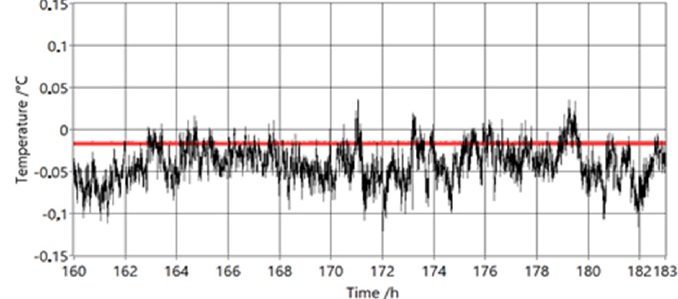
Figure 20. Temperature readings at calibration at ice point (last day). The red colour represents the reference thermometer and the black colour represents the raw un-averaged PAT measurements. The reference thermometer measurements are shown in red and the PAT measurements are shown in black. There was no noticeable drift after one week of